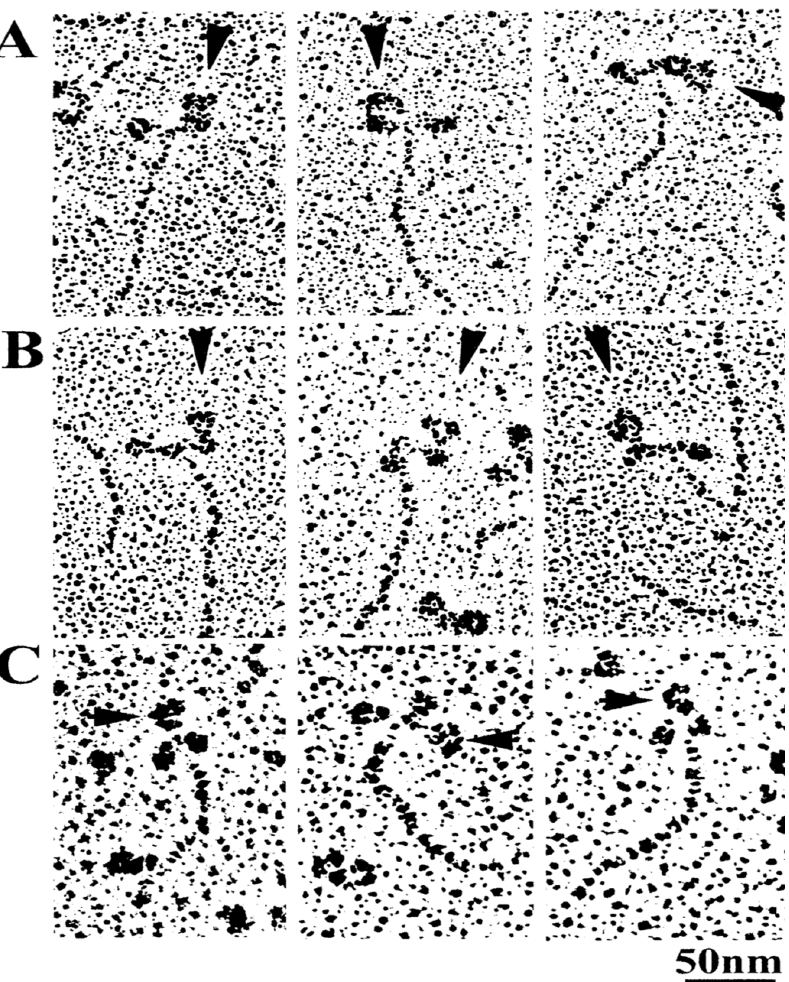
Figure 1. A gallery of electron micrographs of rotary shadowed antibodies (IgG) attached to myosin heads. Anti-CAD antibody- myosin(A), anti-RLR antibody-myosin (B), and anti-LD antibody-myosin (C) complexes are shown in A,B and C, respectively. IgG molecules are indicated by arrowheads. The panels are provided from the published papers (Sutoh et al., 1989; Minoda et al., 2011).